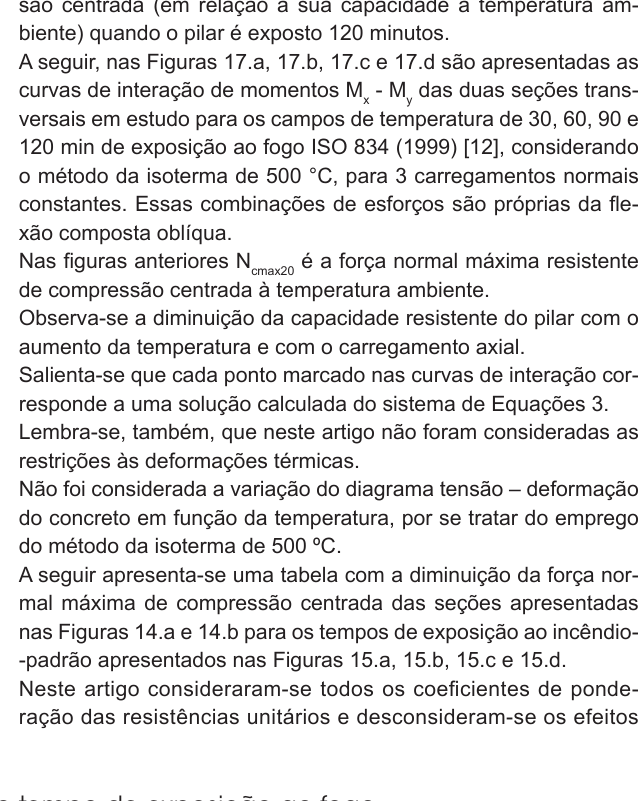
Tabela 1 Diminuição da força normal resistente em função do tempo de exposição ao fogo 30 cm x 30